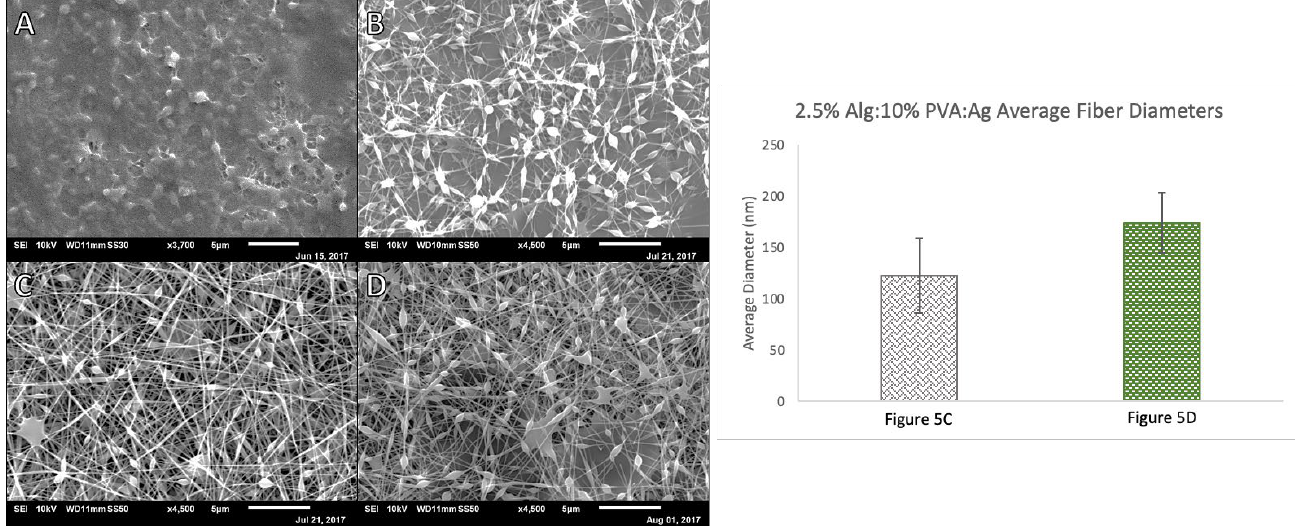
Figure 5. Left: SEM micrographs of Alg-PVA-Ag nanofibers at various ratios and concentrations at 7.5 μL/min and 100 mm. ( A ) 2:1:1 2.5% Alg:10% PVA:1% Ag at 19 kV and 0.5 mL disp.; ( B ) 2:1:1 2.5% Alg:10% PVA:0.5% Ag at 12 kV and 1.0 mL disp.; ( C ) 1:2:1 2.5% Alg:10% PVA:0.5% Ag at 22.8 kV and 1.0 mL disp.; ( D ) 1:2:2 2.5% Alg:10% PVA:0.5% Ag at 22 kV and 1.0 mL disp. Right: Comparison of average Alg:PVA:Ag fiber diameters, n = 40. Each label corresponds to the referenced fiber formulation and spinning conditions described for the micrograph image of the fibers. All fibers formed spun at a rate of 7.5 µ L/min, with a target distance of 100 mm: Figure 5C 1:2:1 2.5% Alg:10% PVA:0.5% Ag at 22.8 kV; Figure 5D 1:2:2 2.5% Alg:10% PVA:0.5% Ag at 22